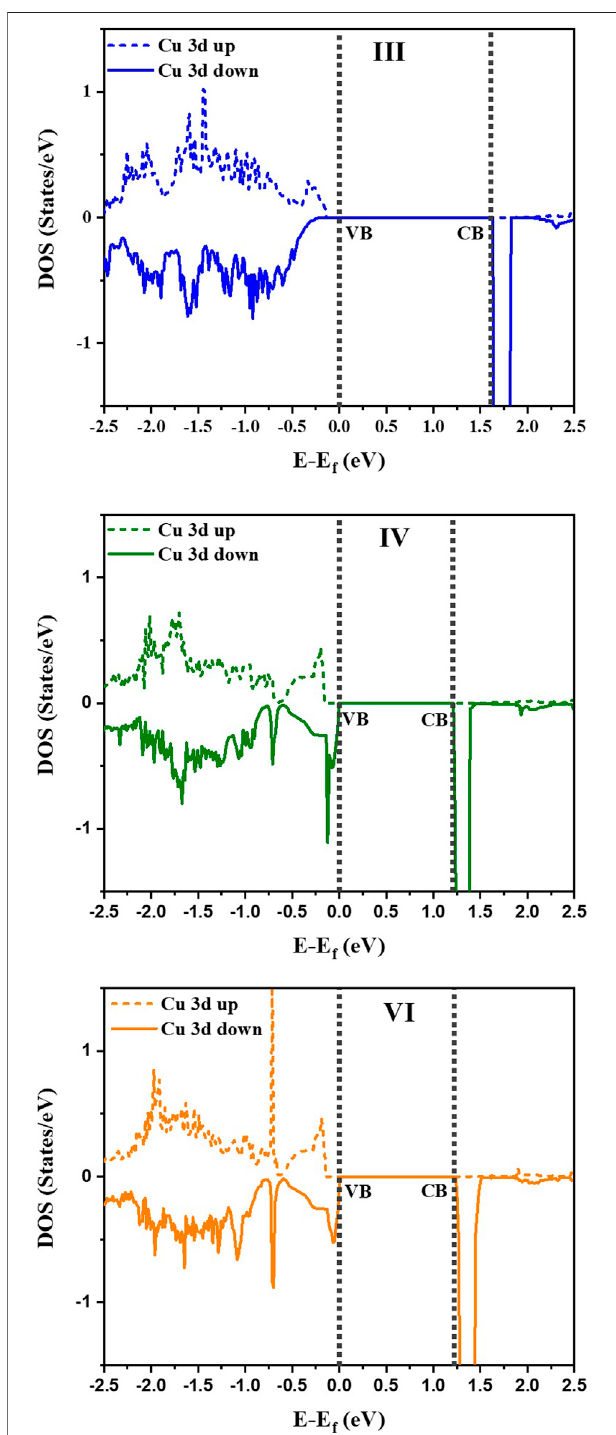
FIGURE 4 | Partial Density of States (PDOS) for Cu 3d spin up and spin down states for the con fi gurations III, IV and VI. Vertical dotted lines represent VB and CB of the three doped con fi gurations. The zero of energy is the valence band maximum.